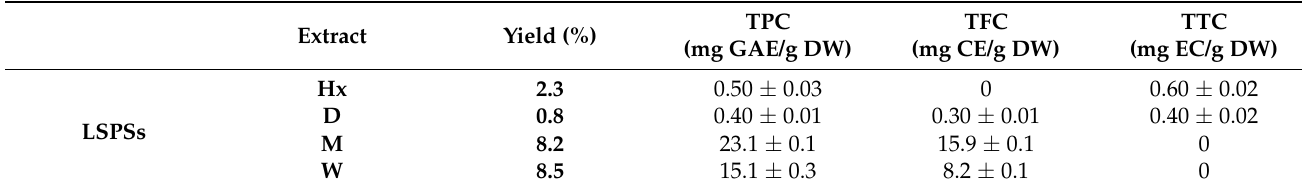
LSPSs: Leafy Stem of Phagnalon saxatile. Hx: Hexane, D: Dichloromethane, M: Methanol, W: water, TPC (total phenolic content), TFC (total flavonoid content), TTC (total tannin